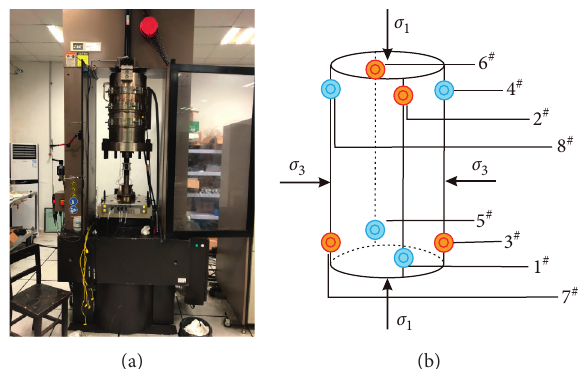
Figure 1: Experimental instruments: (a) MTS 815 servohydraulic testing system and (b) sketch of AE sensors